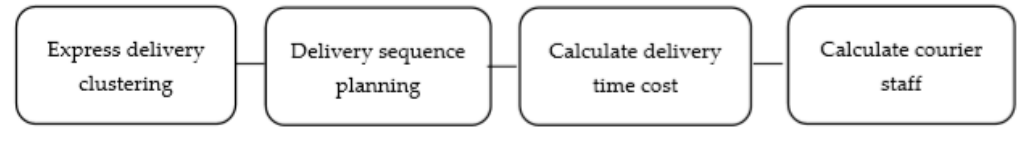
Figure 11. Industrial applications.